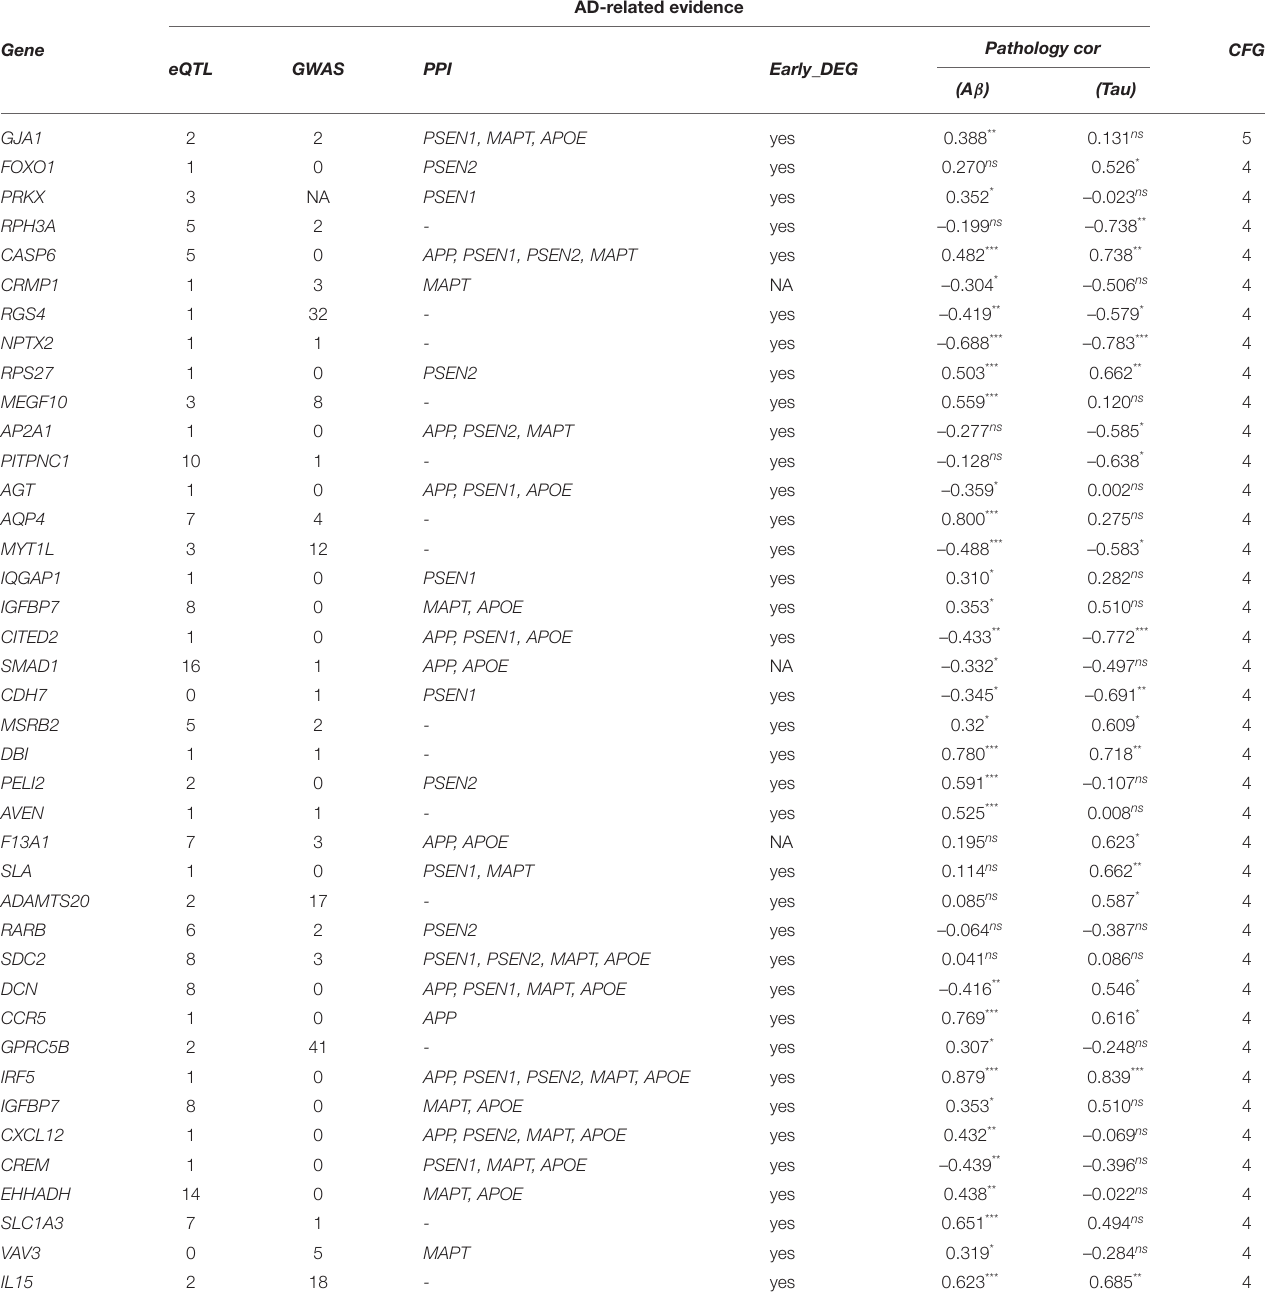
TABLE 4 | The 40 potential driver genes are prioritized by the CFG method based on AlzData